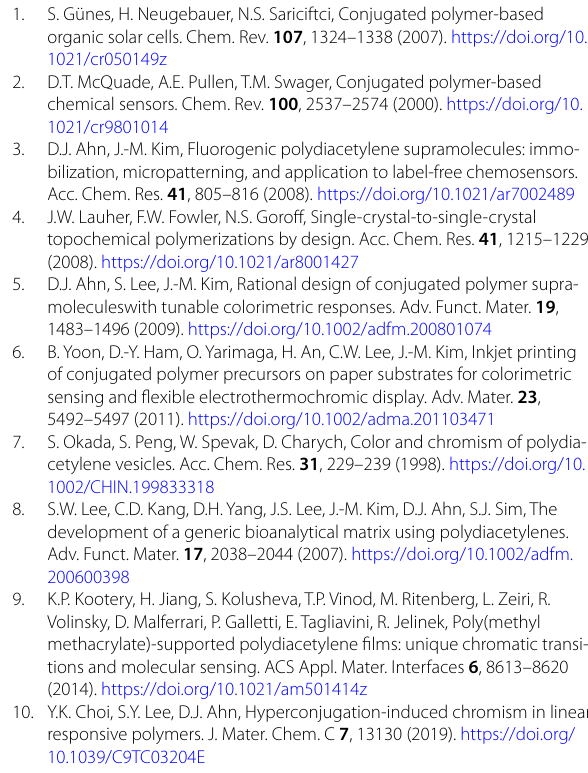
water. Figure S10 . TEM images of TCDA/silica. Figure S11 . Visible spectra of polymerized TCDA vesicles and TCDA/Silica particles with 10 mM of chemical stimuli. Figure S12 . PL spectra of polymerized TCDA vesicles and TCDA/Silica particles with 10 mM of chemical stimuli (Excitation at 490 nm). Table S1 . FT-IR peak assignment of Figure 1d. Table S2 . Colorimetric response (CR) values of TCDA vesicles and redispersed TCDA/silica